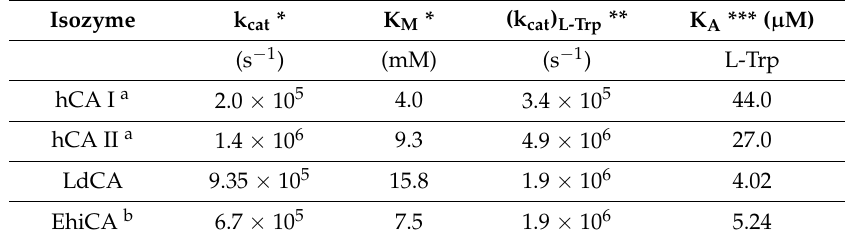
Table 1. Activation of human carbonic anhydrase (hCA) isozymes I, II, and EhiCA with L-Trp at 25 ◦ C for the CO 2 hydration reaction [38].